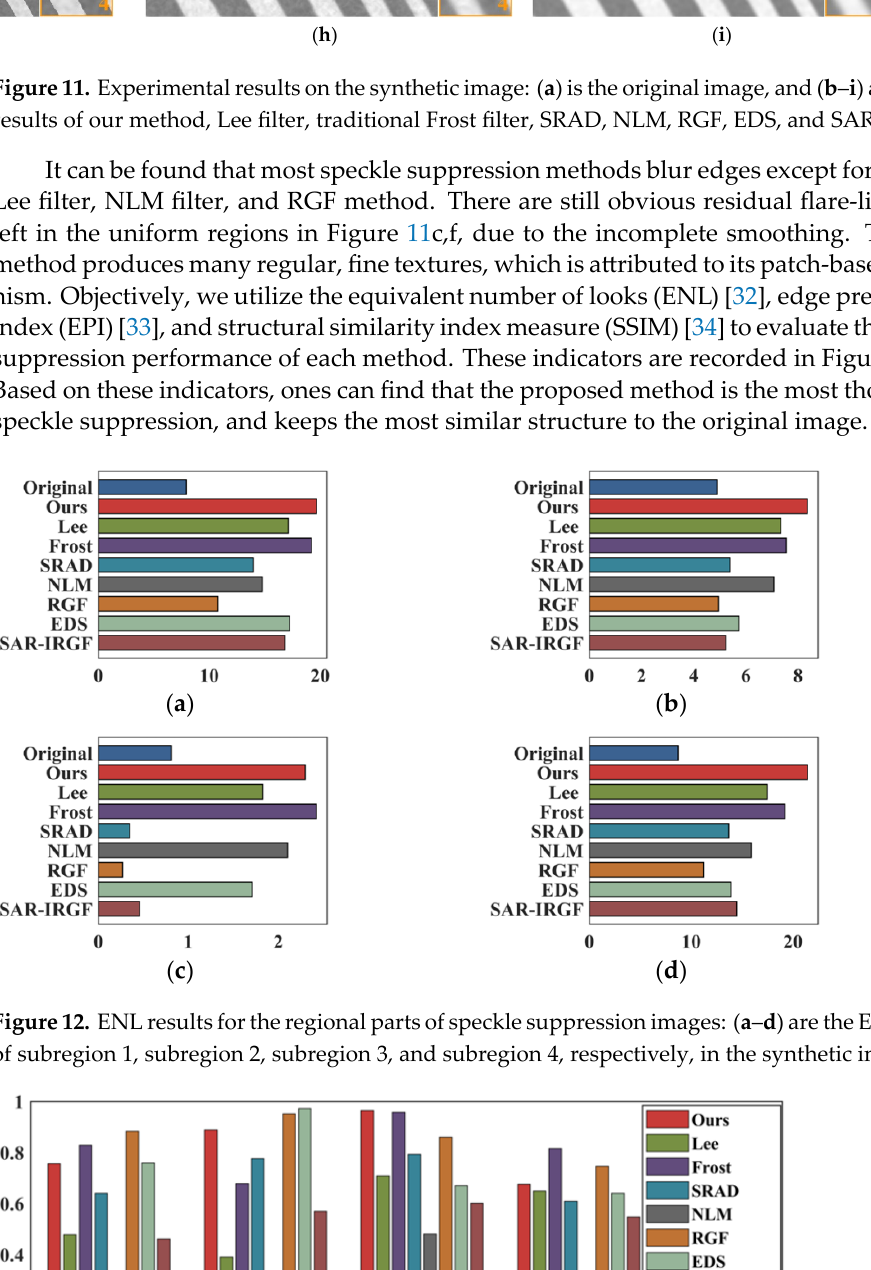
Figure 14. SSIM results for the speckle suppression on synthetic image. Next, four optical images are utilized to test the performance of our method in real- world scenes. Note that, due to many features existing in the plant, the clamps, and the keyboard, we add less speckle with a standard deviation of 0.03 on them. The speckle with a standard deviation 0.06 pollutes the Apple, in order to verify the methods’ filtering abil- ity. The filtering results are presented in Figure 15. According to Figure 15, one could easily find that our method protects features better visually while speckle is removed, especially the preserved letters on the keyboard for example. Furthermore, the compari- sons of ENL, EPI, and SSIM for all the results in Figure 15 are illustrated in Figure 16. Based on Figure 16, one could find that the proposed method performs best speckle sup- pression in most cases with satisfying feature preservation. ( a )